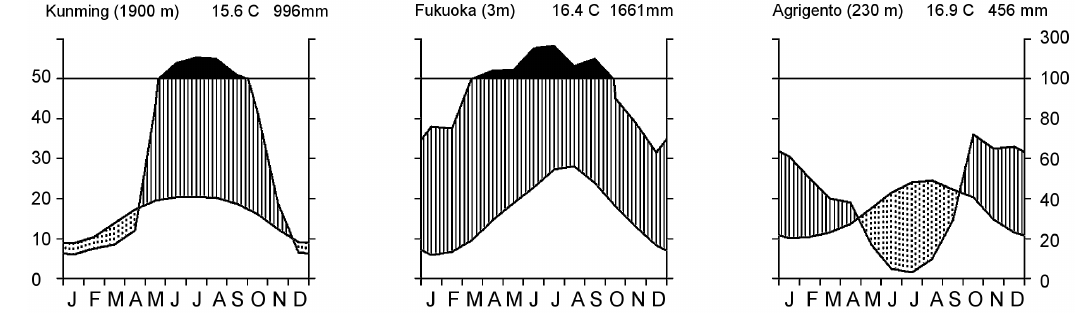
Figure 2. Climate diagrams of the type introduced by Walter and Lieth [18] constructed for sites representative of subtropical montane semi-moist forest (Kunming, winter-dry), warm temperate rain forest (Fukuoka, no dry season) and Mediterranean-climate sclerophyll forest (Agrigento, summer-dry); for each site, altitude, mean annual temperature and mean annual rainfall are given at the top of the diagram; where mean monthly rainfall exceeds 100 mm, the amount in excess of 100 mm is given using a compressed scale (one tenth of that used for values up to 100 mm); the original data were taken from the WorldClim Global Climate Data website